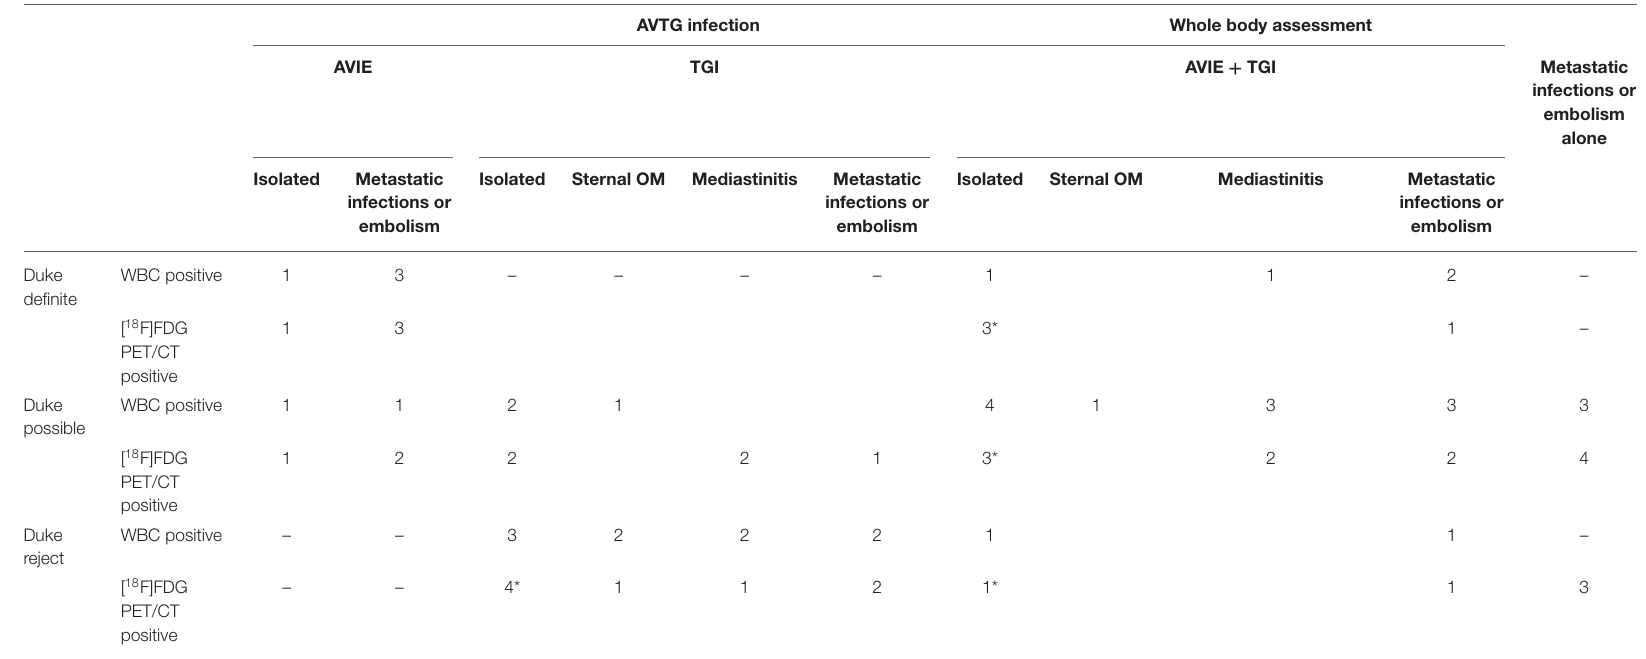
TABLE 7 | Comparative assessment of 99m Tc-HMPAO-WBC SPECT/CT and [ 18 F]FDG PET/CT in 22 patients with early/very early infections as for site of uptake identified; * including 1 FP in each. AVTG